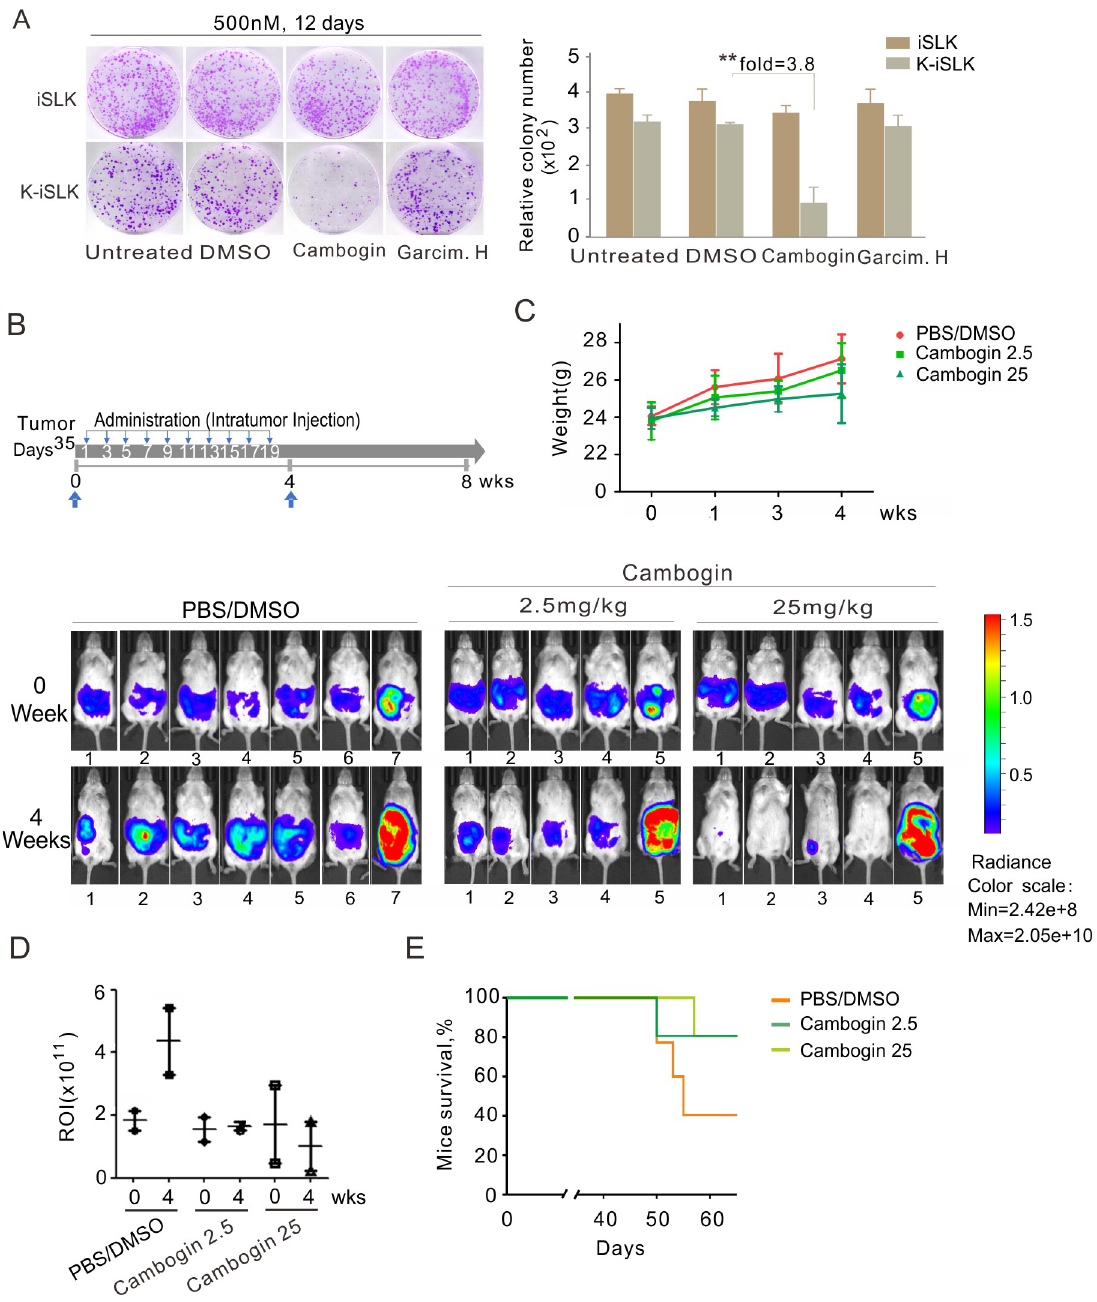
Fig 7. Cambogin significantly inhibits KSHV-latently infected cell growth in vitro and i n vivo . ( A ) Cambogin selectively reduced the colony formation in KSHV-latently infected cells in vitro . Equal amounts of iSLK and KSHV-latently infected iSLK-K cells were individually inoculated and treated with or without Cambogin and Garcimultiflorone H and subjected to colony formation assays as indicated. The cells were fixed 12 days later and stained with crystal violet to determine colony number. A representative well with colony formation is shown. Right panel , the relative amount of colony formation was calculated from three independent experiments. Double asterisks indicate p < 0.01. ( B ) Cambogin inhibited tumor progression in a xenograft mouse model of primary effusion lymphoma. The tumor burden of NOD/SCID mice was analyzed by luminescence assay at week 5 and then following treatment with PBS/DMSO, or Cambogin every other day for 3 weeks. Top panel, schematic of NOD/SCID mice intraperitoneally engrafted with ten million BCBL1-Luc cells for 35 days, and then untreated or treated with same amount of Cambogin every other day for 20 days. ( C ) Weights of NOD/SCID mice intraperitoneally engrafted with 10 7 BCBL-Luc cells for 5 weeks and then treated with Cambogin, every other day, for 3 weeks, were monitored every week. ( D ) Luminescent signals were quantified and expressed in region-of-interest (ROI) signal intensity [total radiant efficiency( p / s )/( μ W/cm 2 )] in panel B. ( E ) Total percentage of mouse survival in each group is shown in panel B.